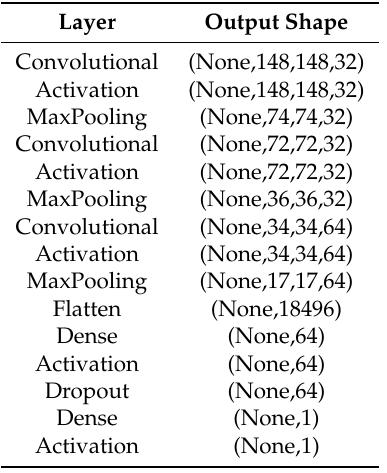
Table 2. Structure of convolutional neural network used for image classification.